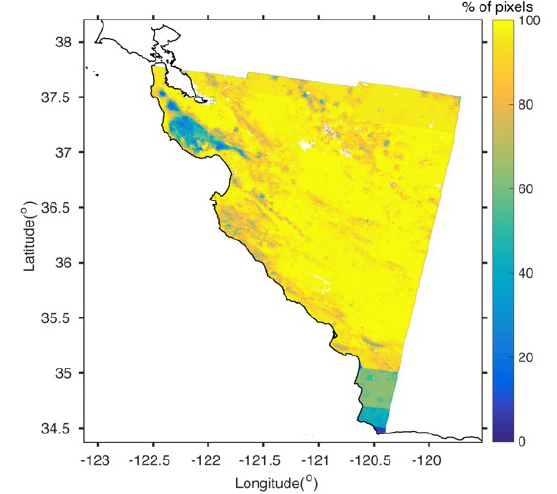
Figure 5. Map view of the number of pixels (in percentage) with coherence above the selected threshold 0.6 for all interferograms. This provides a good indication of the coherent area. The derived InSAR LOS displacement time series were validated against GPS time series at the same locations, projected to the S‐1 LOS. We differentiated the GPS time series with regard to the GPS site (P305) located at the same location as the reference pixel used in the InSAR time series analysis. This removed the datum difference between the two data sets and ensured that the GPS time series were comparable to the InSAR measurements. Taking the differential positioning with